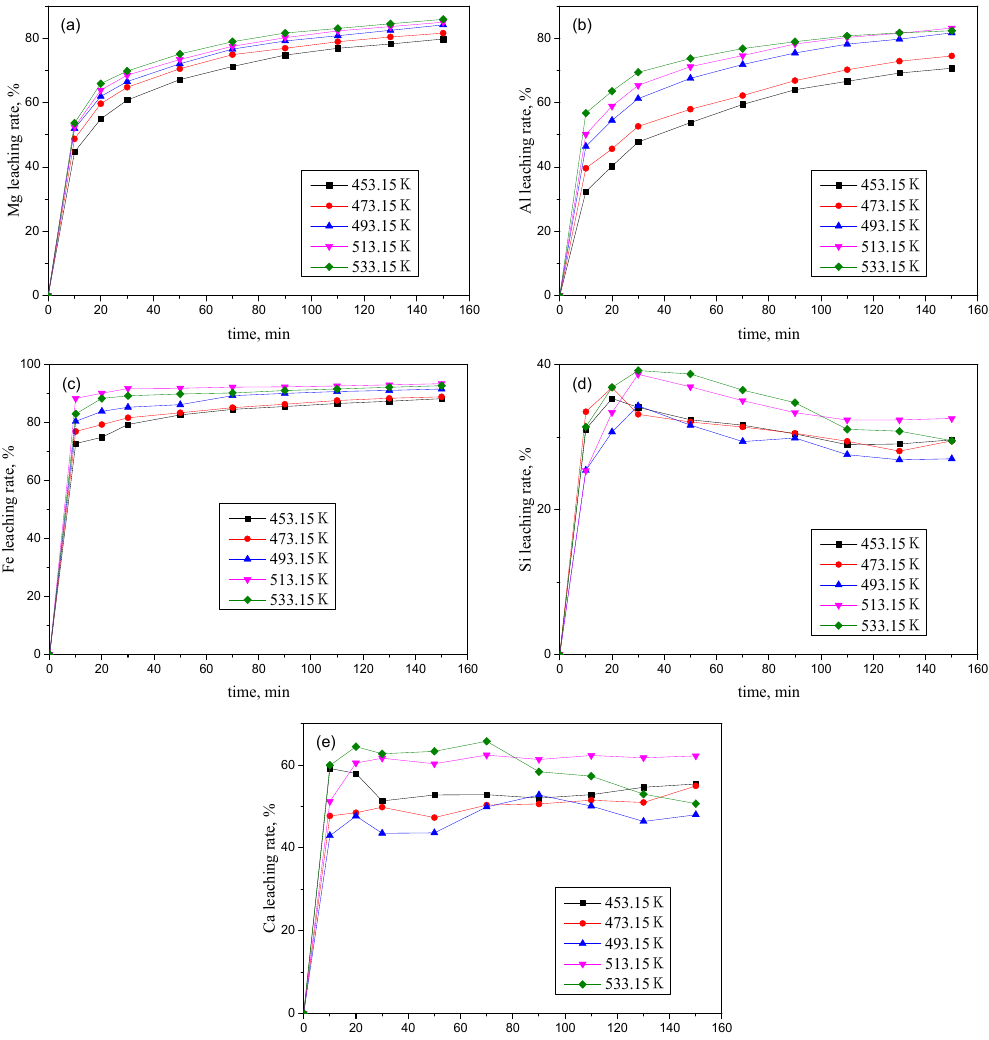
Figure 4. Effects of temperature on the leaching of impurities: ( a ) Mg; ( b ) Al; ( c ) Fe; ( d ) Si; ( e ) Ca.